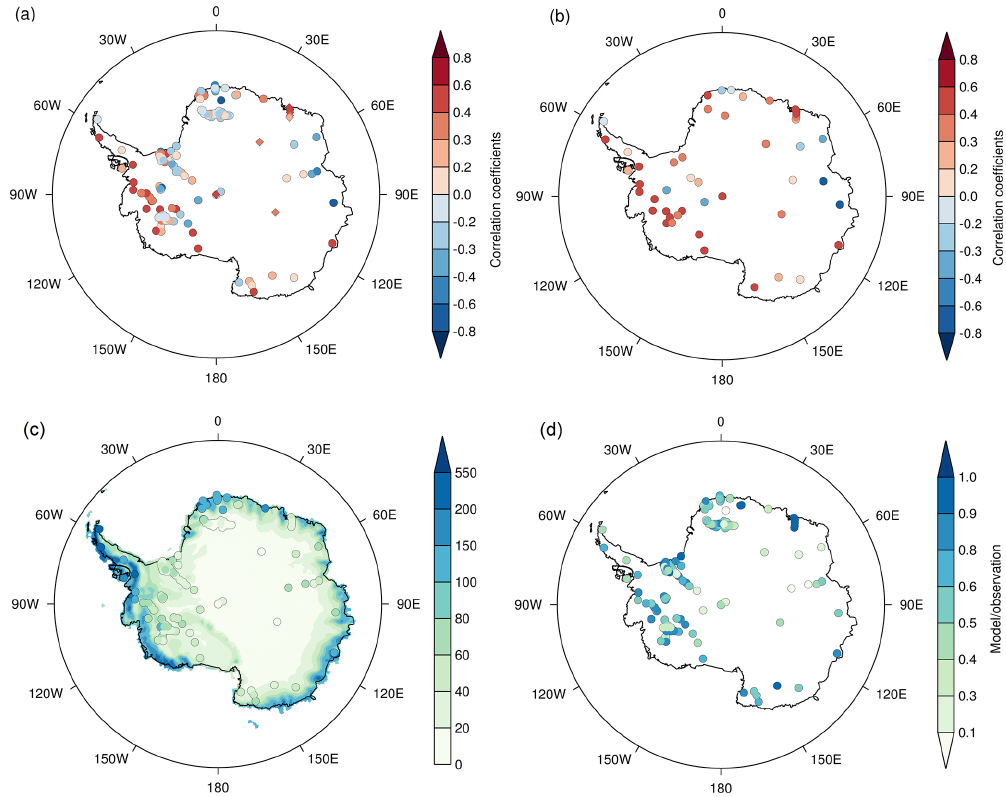
Figure 5. Spatial distribution of the correlation coefficients (a) between annually resolved SMB observation and ERA5 simulations for their overlapping period (circle: ice core; diamond: stake network) and (b) between averaged observed time series in the same location/region and the corresponding simulations from ERA5; (c) standard deviation of annual observed SMB and ERA5 simulations; (d) the ratios of the standard deviation of annual SMB from EAR5 simulations to